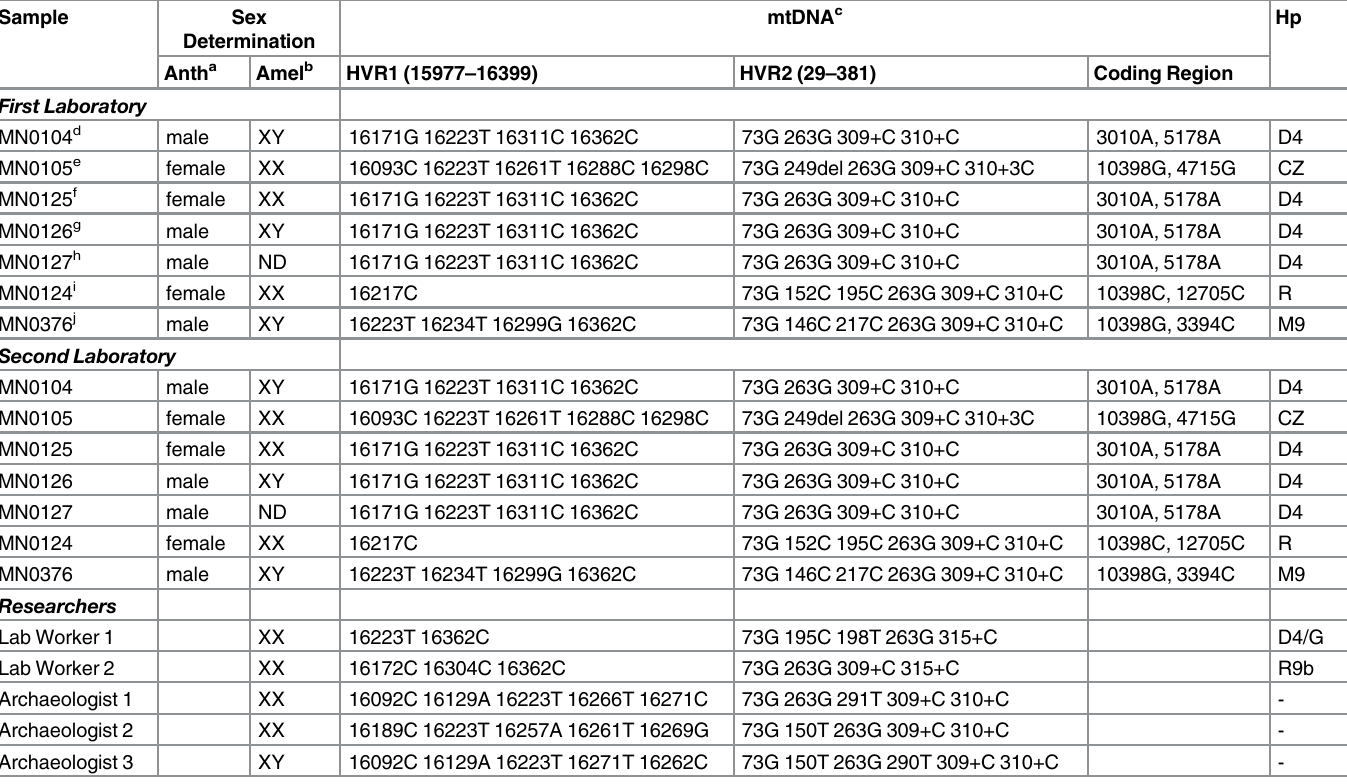
Table 1. mtDNA haplogroups of the Tavan Tolgoi